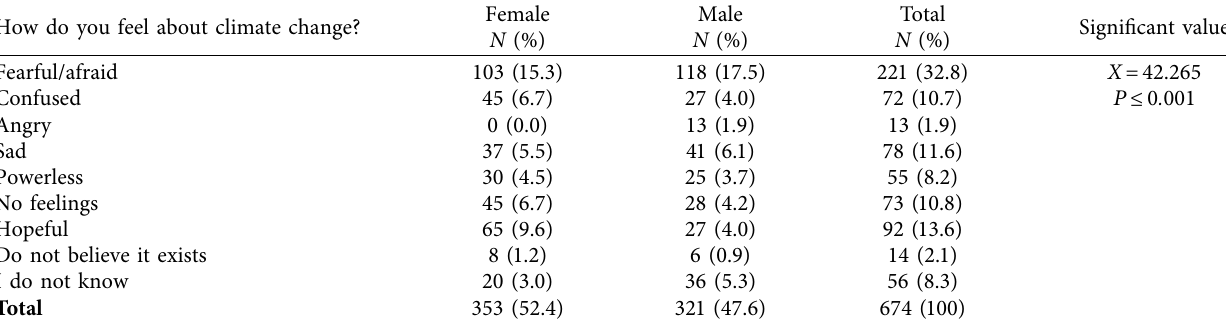
Table 5: Respondents’ feelings towards climate change.